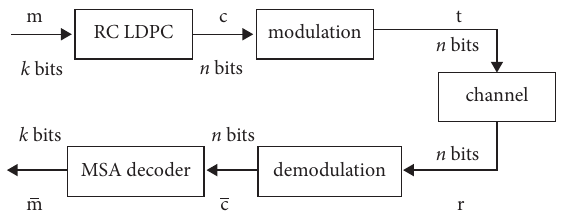
Figure 1: Block diagram of rate-compatible LDPC codes with MSA